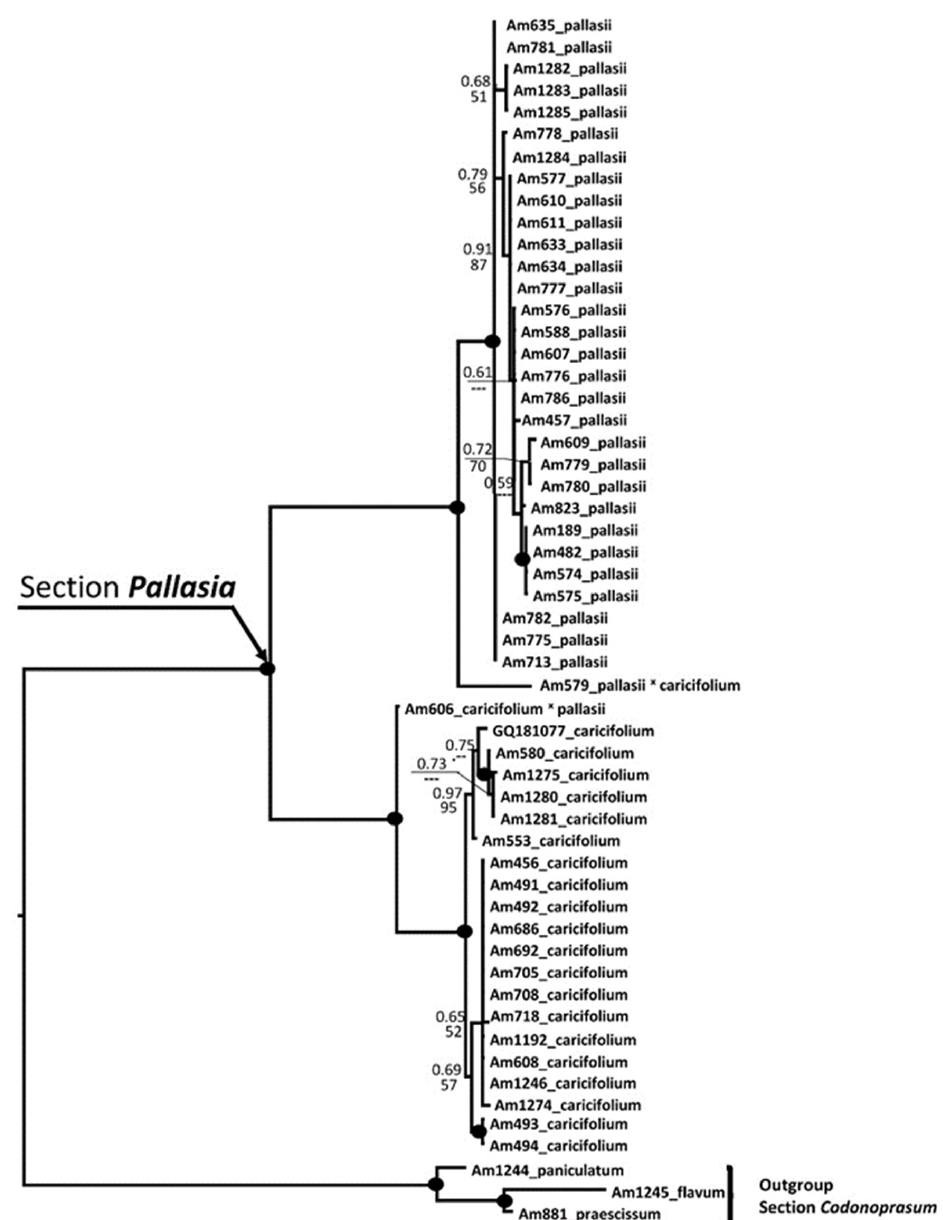
Figure 6. Combined nrITS and plastid ( trn L- rpl 32 and trn Q- rps 16) tree of A. sect. Pallasia . Species from A. sect. Codonoprasum has been used as an outgroup. Numbers by nodes represent bootstrap support (1000 replicates) and Bayesian probabilities. The joint presence of Bayesian probabilities over 0.98 and bootstrap support over 95% is indicated with a black dot. The origin of samples is seen in Appendix A.